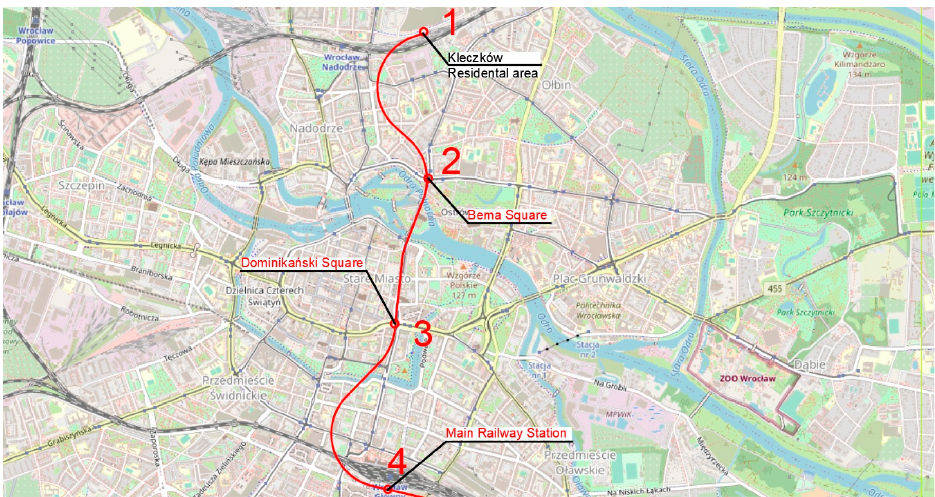
Figure 9. Route five (background: openstreetmap.org). Table 1. Description of routes.